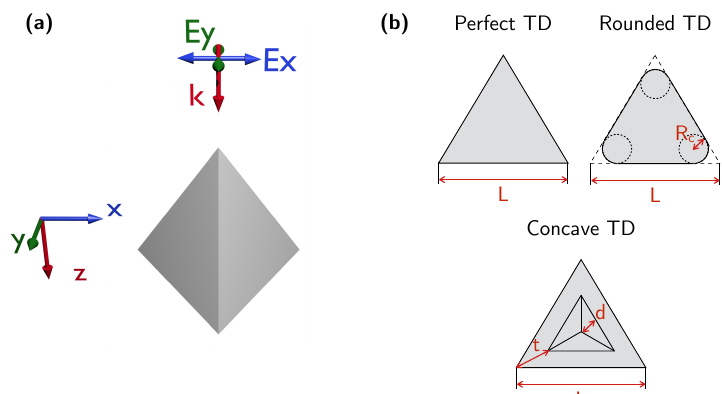
Figure 1. ( a ) Scheme of simulations geometry: the tetrahedrons (TDs) are illuminated with monochromatic plane waves with orthogonal polarization E x and E y under normal incidence k (along the z -direction). ( b ) Scheme of the different deformations introduced to the perfect TD. With red arrows are indicated the parameters that characterize each deformation.